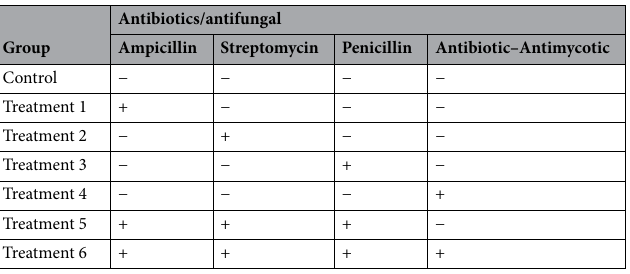
Table 1. Antibiotics and antifungal tested in this study. −: Not added to the cultures, +: Added to the